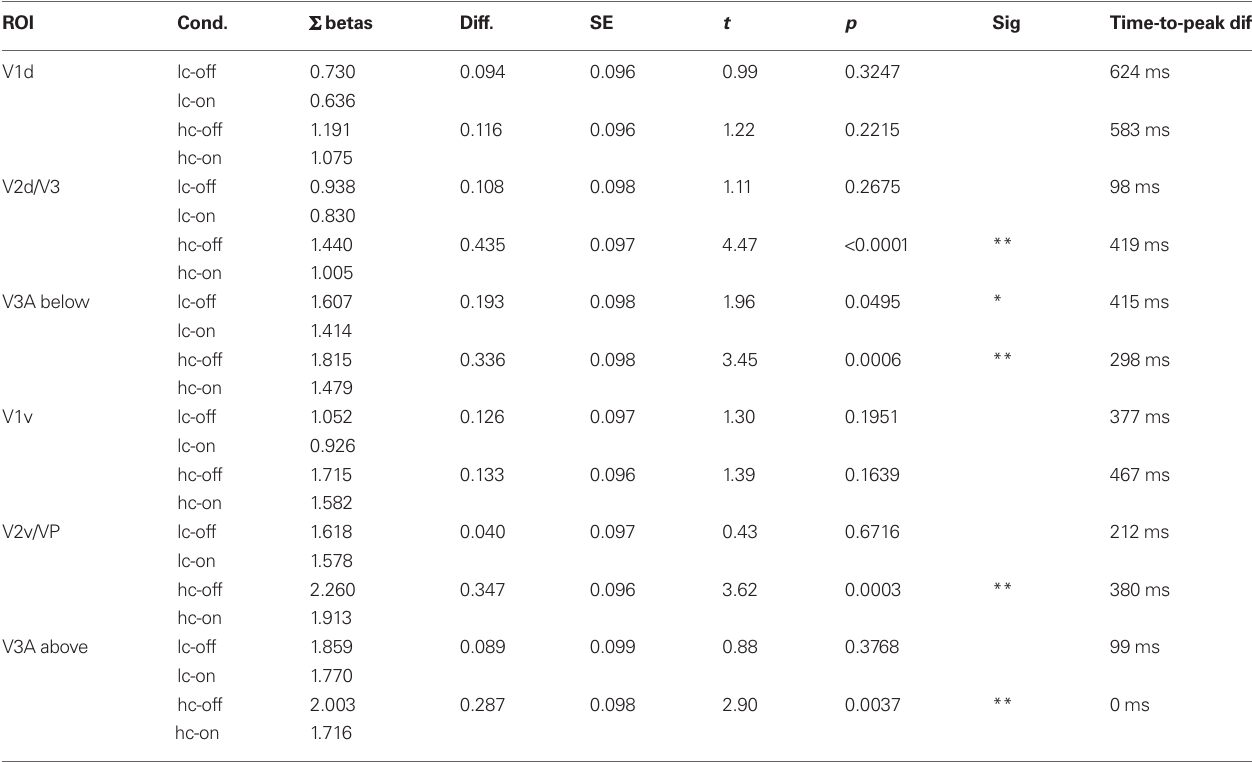
Table 2 | Sum of beta weights for predictors 3–8 s after stimulus onset in each condition for all ROIs (the same data is plotted in Figure 4B ). ROI